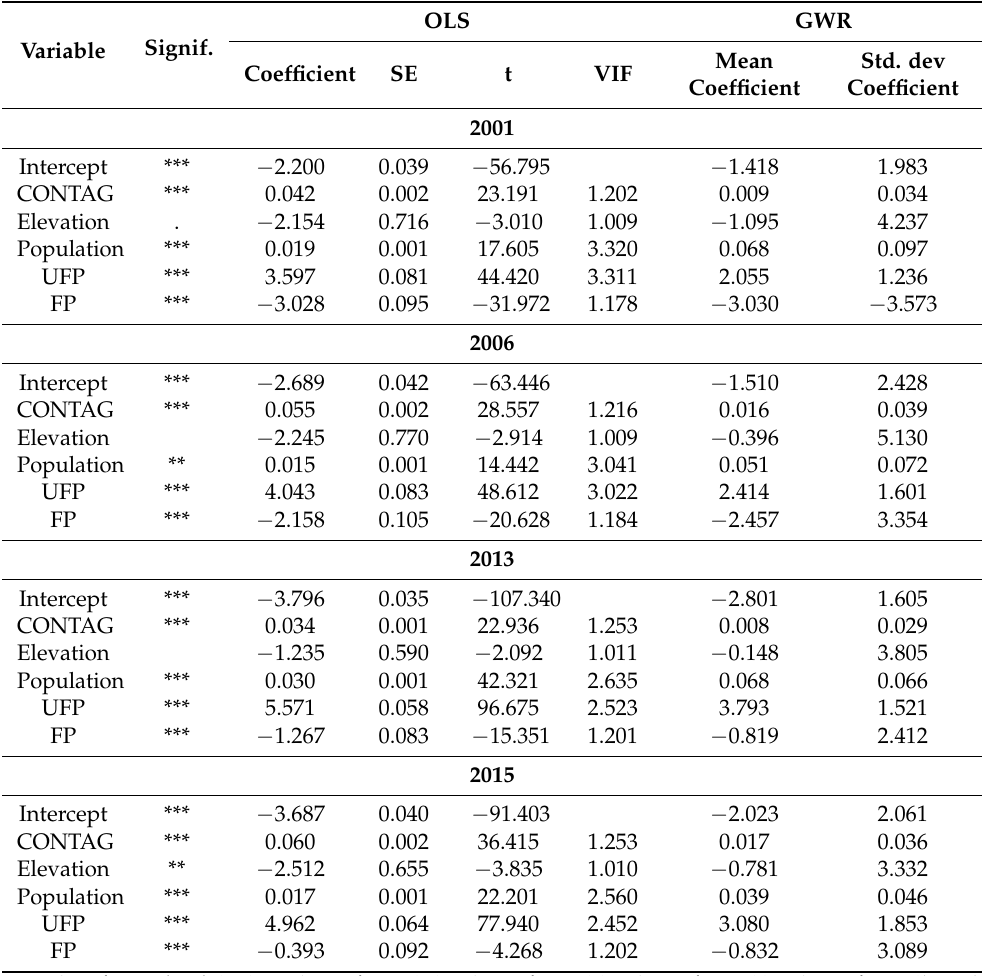
Table 4. Summary of ordinary least squares (OLS) and geographically weighted regression (GWR) coefficients. SE, standard error; VIF, variance inflation factor; CONTAG, contagion index; UFP,